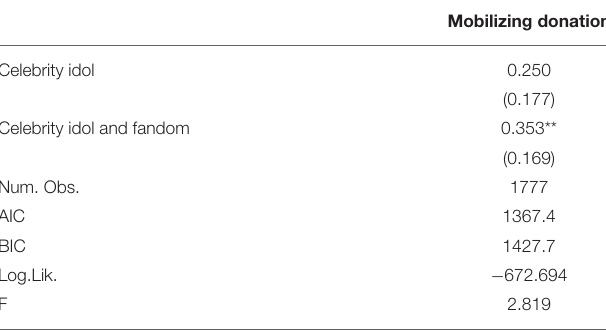
TABLE 2 | Experimental result of mobilizing